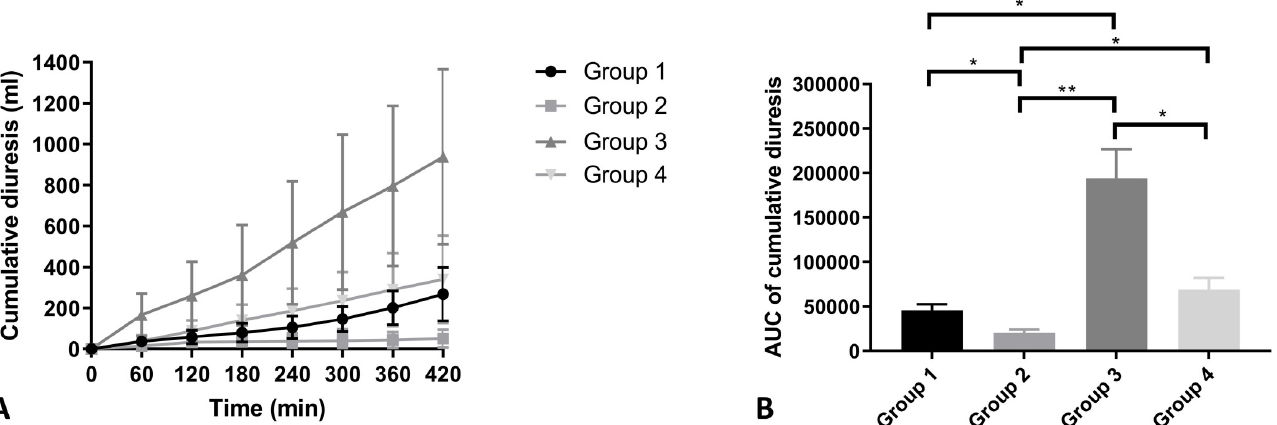
Fig 3. Cumulative diuresis (ml) (A) and AUC (B) of the four experimental groups during NMP (mean + SD). �� indicates a p-value of � 0.01. ��� indicates a p-value of � 0.001.